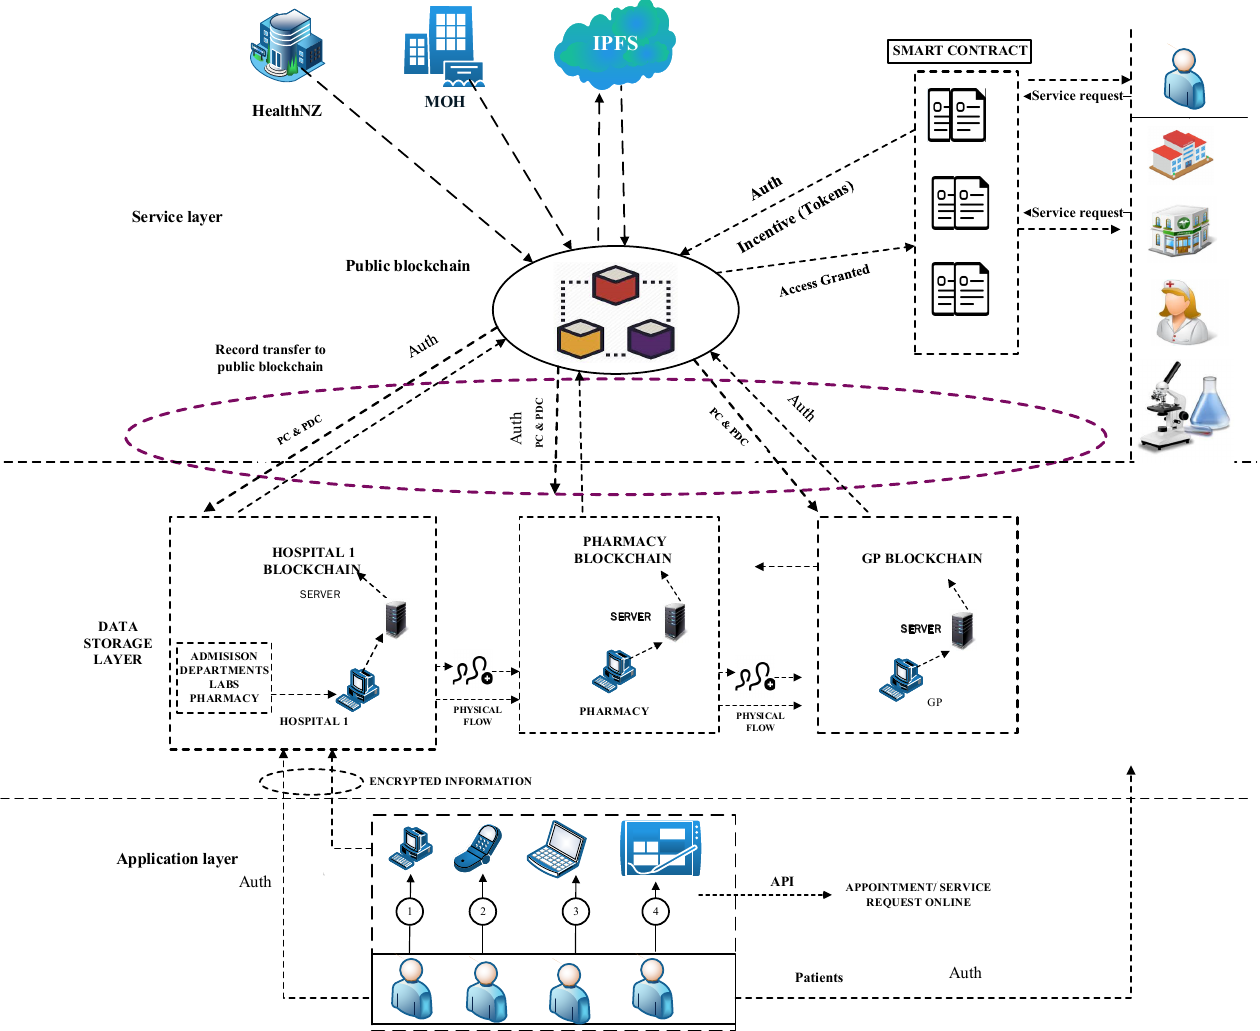
Figure 1. BlockPres